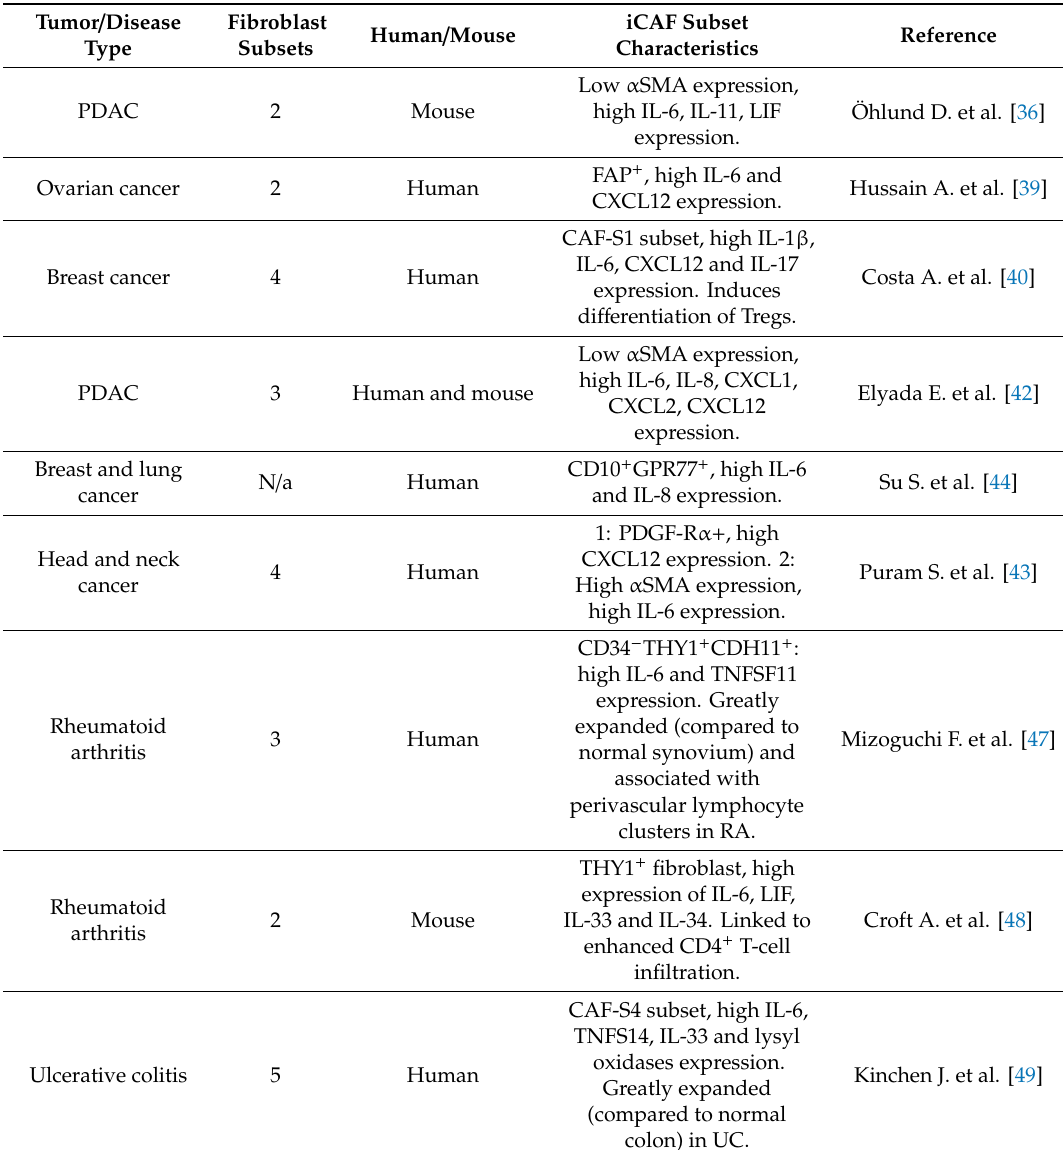
Table 1. Inflammatory fibroblast subset